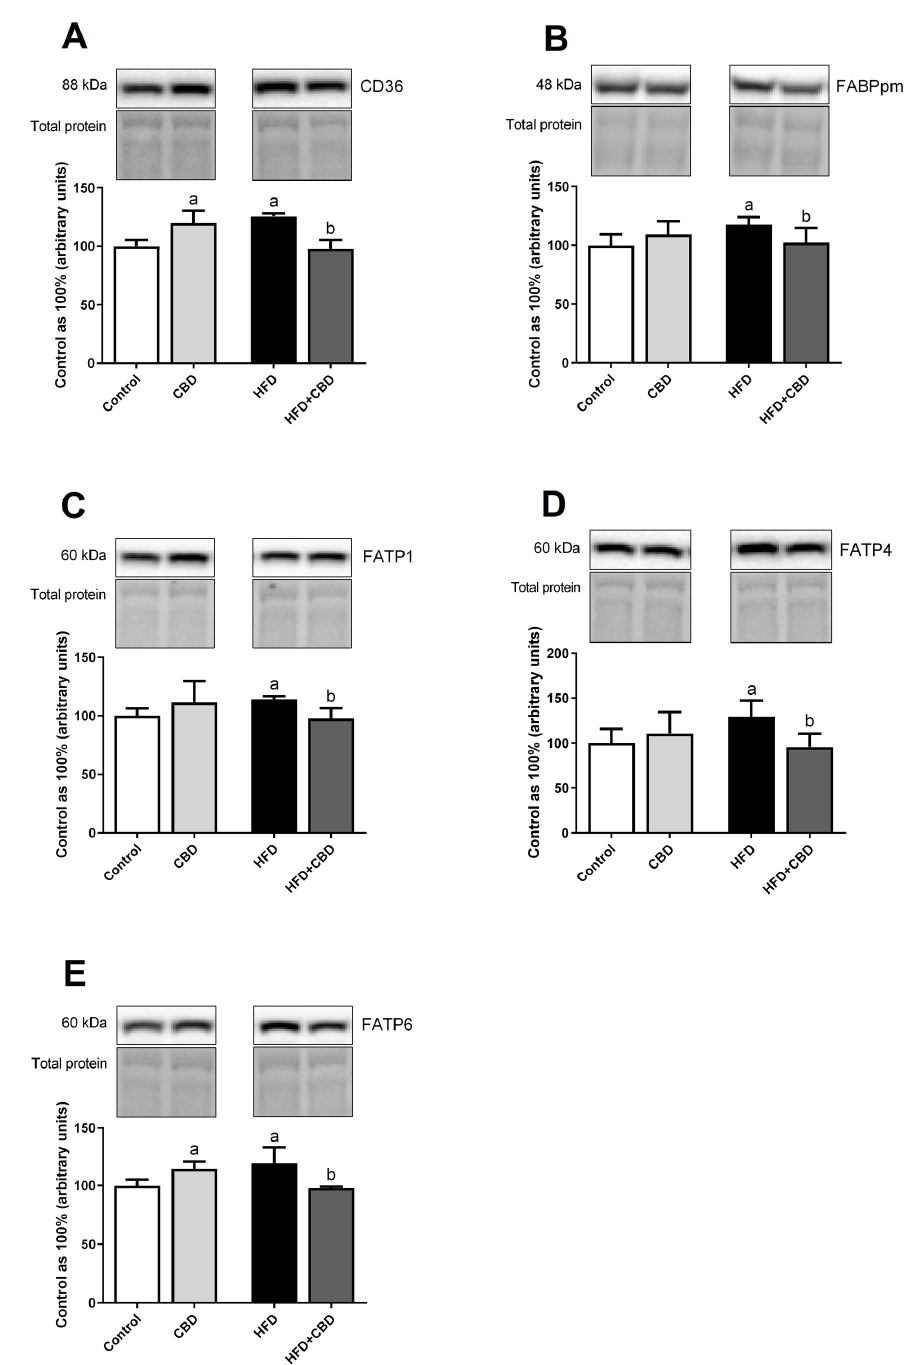
Figure 3. The total myocardial expression of fatty acid transport proteins, i.e., a cluster of differ- entiation/a scavenger receptor class B protein (SR-B2)—CD36 ( A ), plasma membrane fatty acid- binding protein—FABPpm ( B ), fatty acid transport protein 1—FATP1 ( C ), fatty acid transport protein 4—FATP4 ( D ), fatty acid transport protein 6—FATP6 ( E ) in the left ventricle after 2-week cannabidiol (CBD) administration in rats fed a standard diet (Control) or a high-fat diet (HFD). The protein expression was determined by Western blotting method, normalized to the total protein loading in each lane, and presented as a percentage difference in comparison to the control group, which was set at 100%. The results are expressed as mean values ± SD and are based on six independent determinations in each group. a p < 0.05 significant difference vs. control group; b p < 0.05 significant difference vs. high-fat feeding